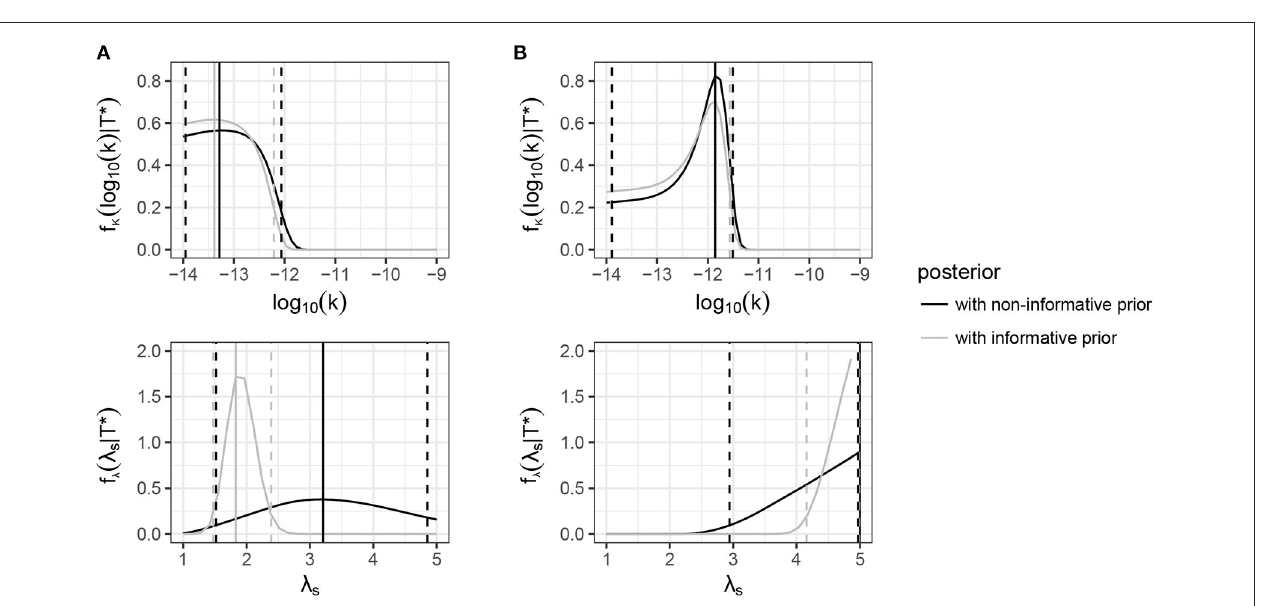
FIGURE 8 | Posterior pdfs for intrinsic permeability k and heat conductivity λ s at both investigated locations, marginalized from the multivariate posterior distributions. Panels (A,B) refer to the two LOMOS-mini measurement datasets presented in Figure 6 , corresponding to an infiltration and an exfiltration case study respectively. The black lines represent the posterior derived from non-informative priors and the gray lines represent the posterior derived from informative priors. The solid vertical lines represent the maximum a posteriori estimate and the dashed vertical lines represent the 95% posterior credible